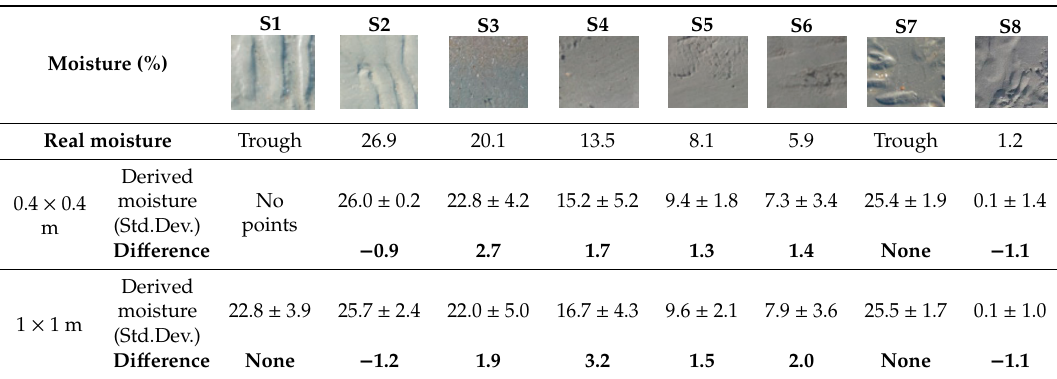
Figure 10. ( a ) Beach surface with the original intensity of four survey lines before correction and ( b ) beach surface moisture content of the same four survey lines after correction. Table 5. The difference between the real sample moisture contents and the derived moisture content based on eight sand samples collected from the target beach.